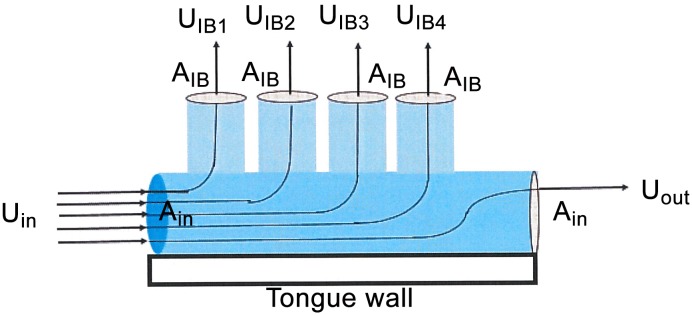
Schematic diagram of weakening axial flows (APT flows in balaenids) via mass loss via IB flows through a cross filter.The principle of mass flow rate conservation dictates that the exiting axial flow (Uout) becomes weaker after sequentially losing mass to filter surface outlets (of cross-section area AIBi). In other words, and with the speeds through the outlets denoted as UIBi, the principle dermands that the inlet and outlet flow speeds be related as follows in the case of a schematic four-plate baleen system: ρUoutAin = ρUinAin
- ρAIB
UIB1
- ρAIB
UIB2
- ρAIB
UIB3
- ρAIB
UIB4) = ρUinAin
- ρAIB
4‹UIB›. Symbols ρ and ‹UIB› correspond to the flow’s mass density and to the IB canal flow speed averaged over all four outlets, respectively.